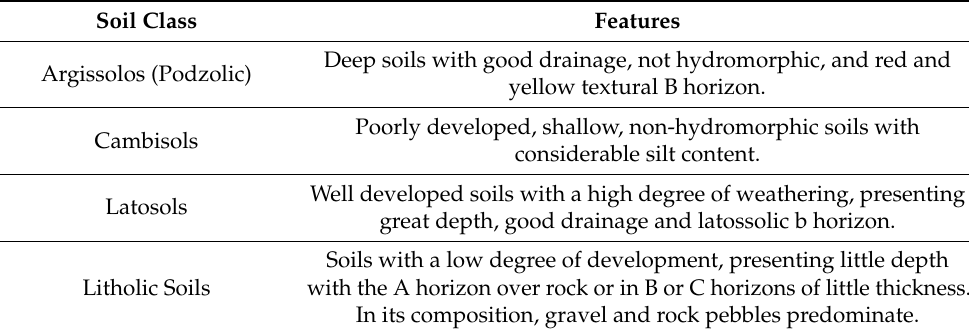
Table 3. Soil parameters and their sources. Soil